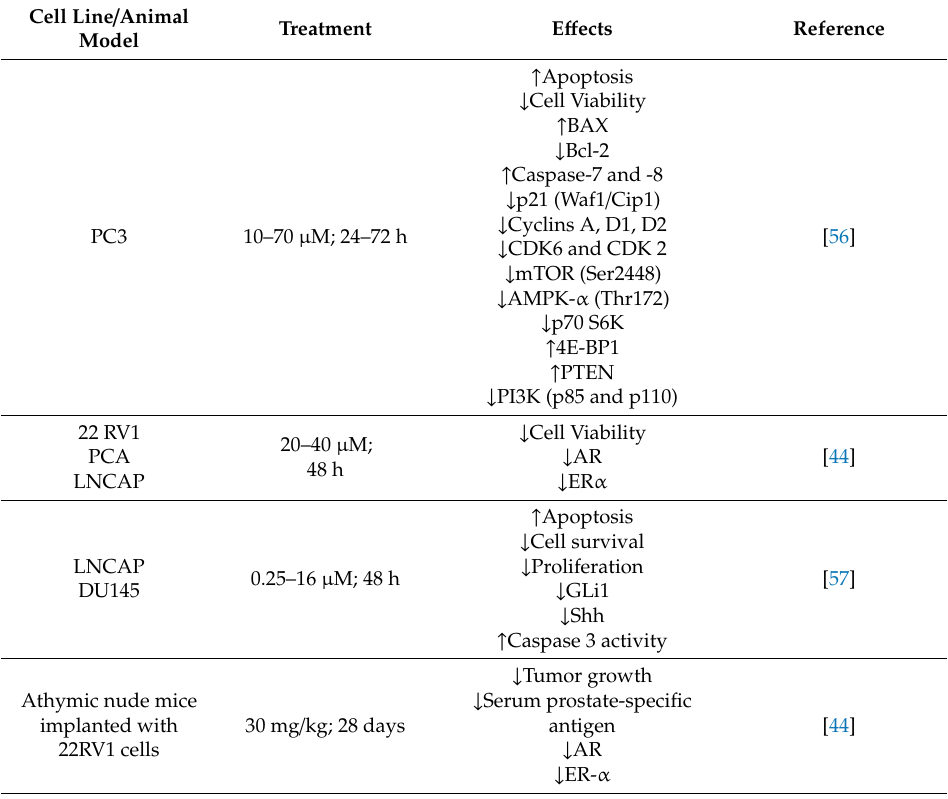
Table 6. E ff ects of carnosol on prostate cancer in vitro and in